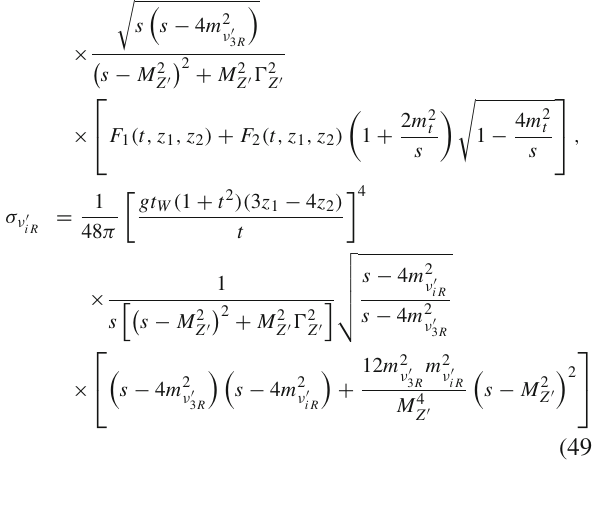
Fig. 6 Allowed parameter region given by the green region in the g 2 / g 1 − M Z (cid:2) plane for several values of z 1 and z 2 , with m ν (cid:2) The region above the blue curve is excluded by the upper bound of the DMrelicabundance,whereastheregionsbelowtheblackandredcurves